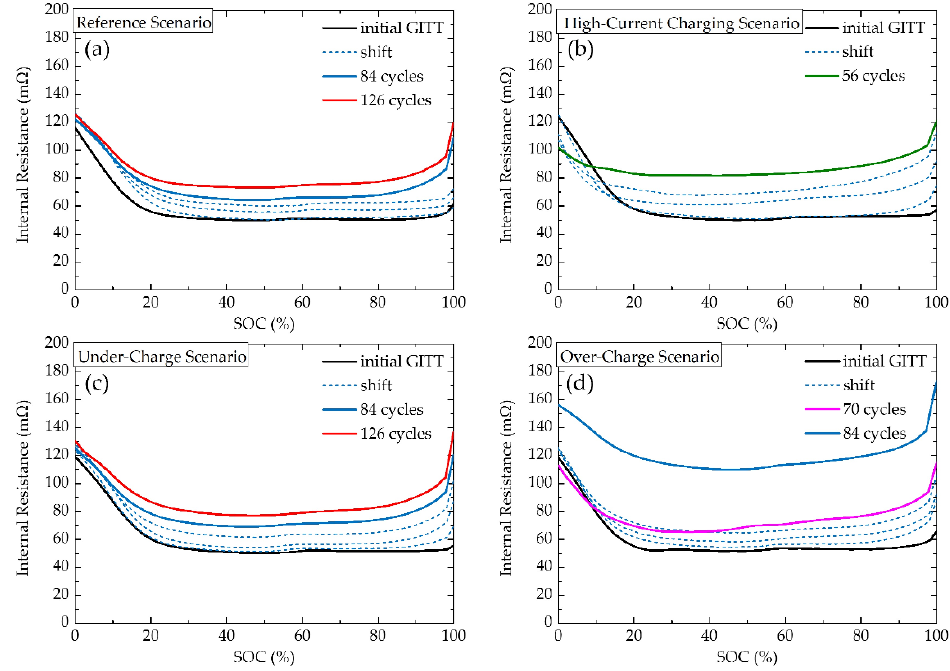
Figure 9. Internal Resistance calculated from GITT measurements, where ( a ) refers to Reference Scenario , ( b ) High-Current Charging Scenario , ( c ) Under-Charge Scenario , and ( d ) Over-Charge Scenario.